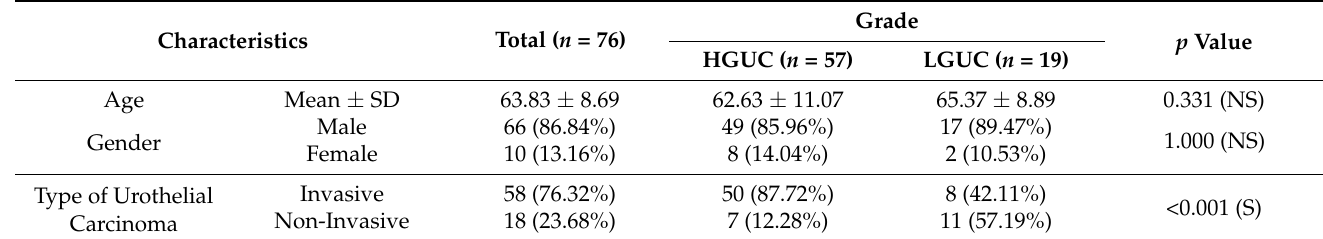
Table 2. Basal demography of patients ( n = 76).